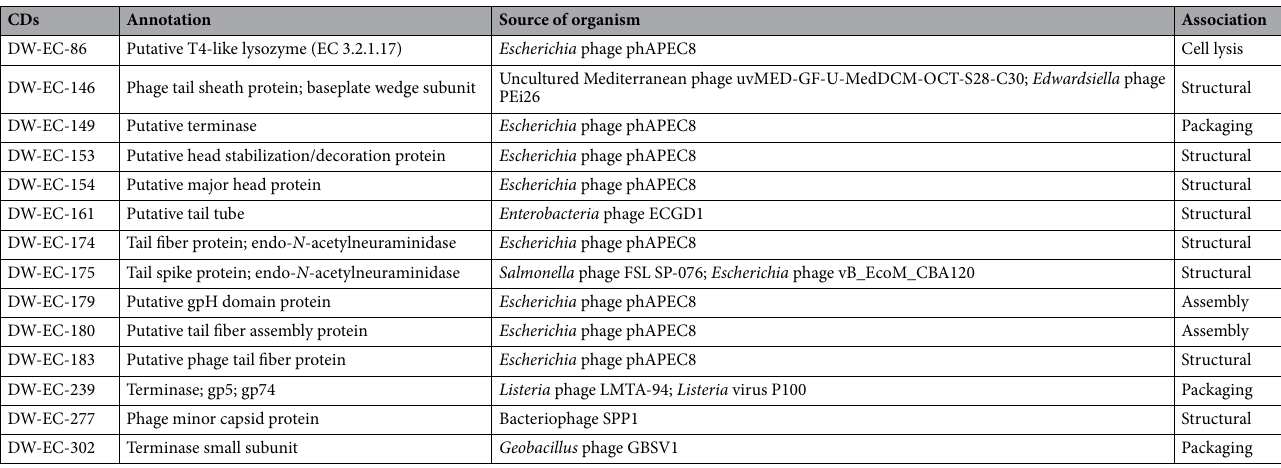
Table 1. Notable DW-EC annotation results.